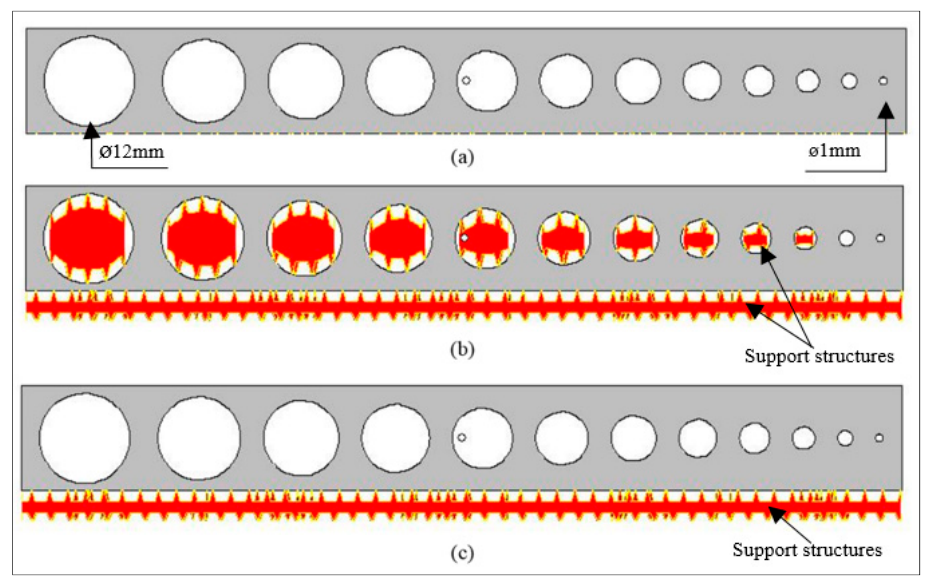
Figure 1. Design of the round overhang holes.